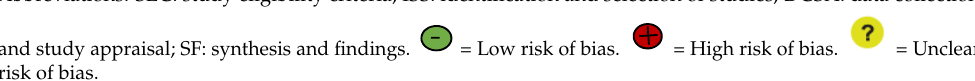
Table 2. Quality assessment of included reviews using the ROBIS tool.